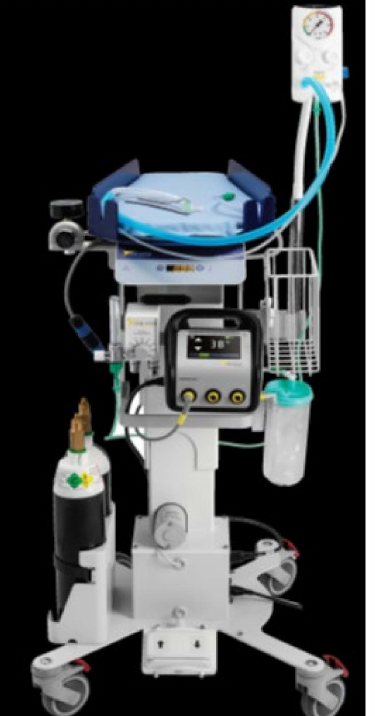
Figure 2. The resuscitation table Lifestart is easily maneuverable, with ergonomic top for placement of the baby. It is equipped with a neonatal warming system, a built-in timer that tracks clamping delay, and a suction device. The baby is warmed from under the patient, ensuring that there is no impediment to resuscitation maneuvers. The electrically operated raising and lowering mechanism allows the nursing platform to be easily positioned at the optimal height for each individual situation and adjusted as necessary. All the resuscitation equipment can be positioned close to the mother and adapted for all types of delivery: natural; assisted; or caesarean